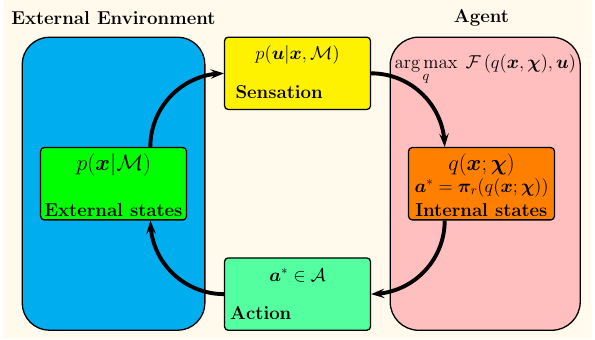
Figure A1. Interaction between an agent and the external